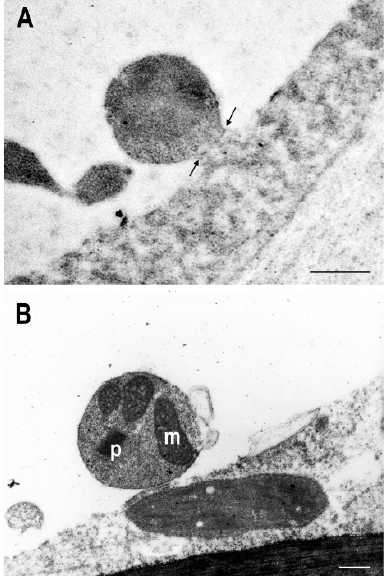
Figure 7. Green pepper var. Galena. Details of vesicles in the vacuole: ( A ) formation of the vesicle still connected to the cytoplasm (arrows) and ( B ) vesicle containing different organelles, mitochondria (m) and peroxisome (p). Scale bar = 500 nm.